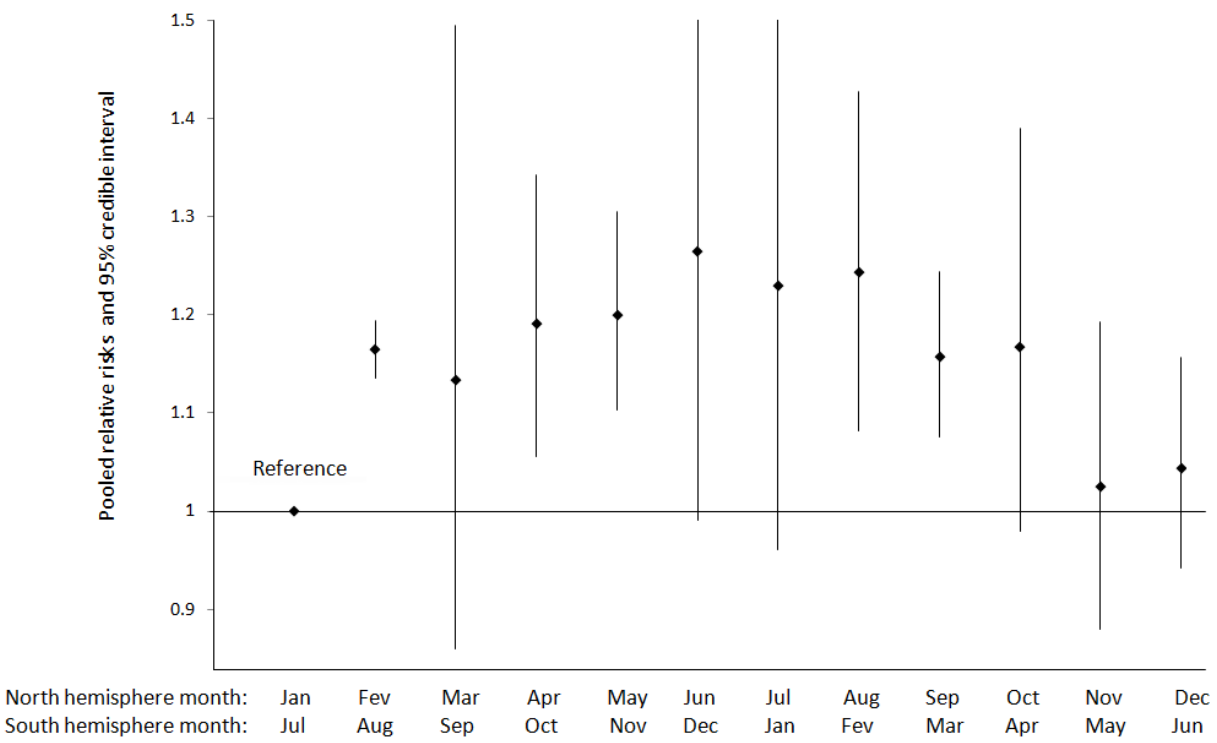
Figure 1. Pooled relative risks and 95% credible interval for the variation in preeclampsia incidence by month of conception ( N = 530,160 births).